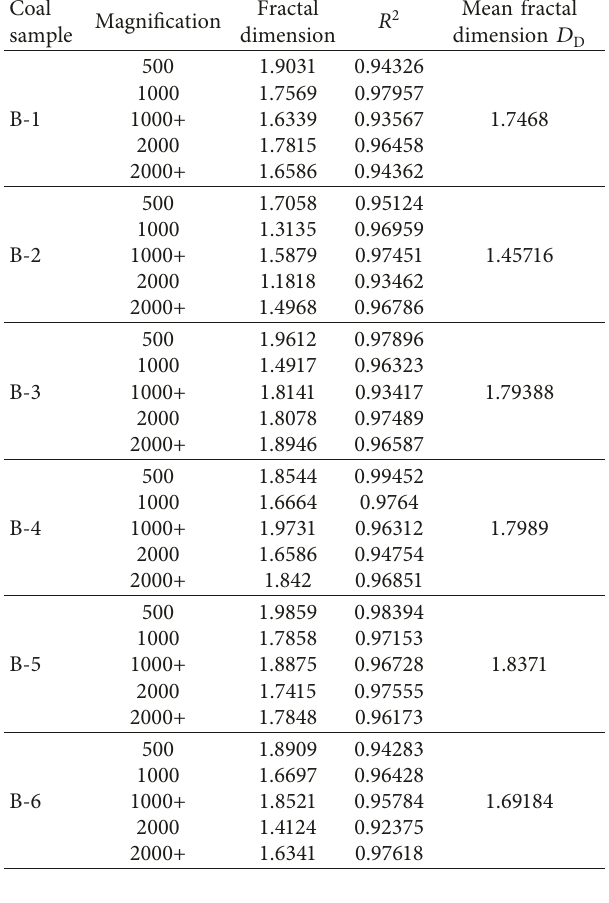
Table 2: Fractal dimensions of pore distribution of raw coal samples.